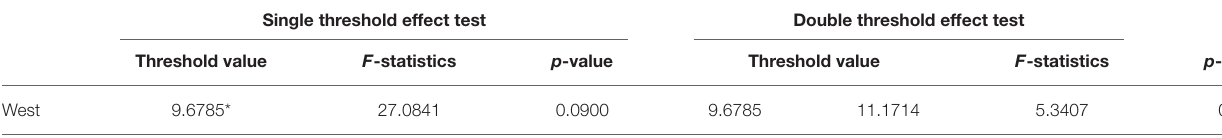
TABLE 5 | Results of threshold effects between air pollution and health care expenditure.